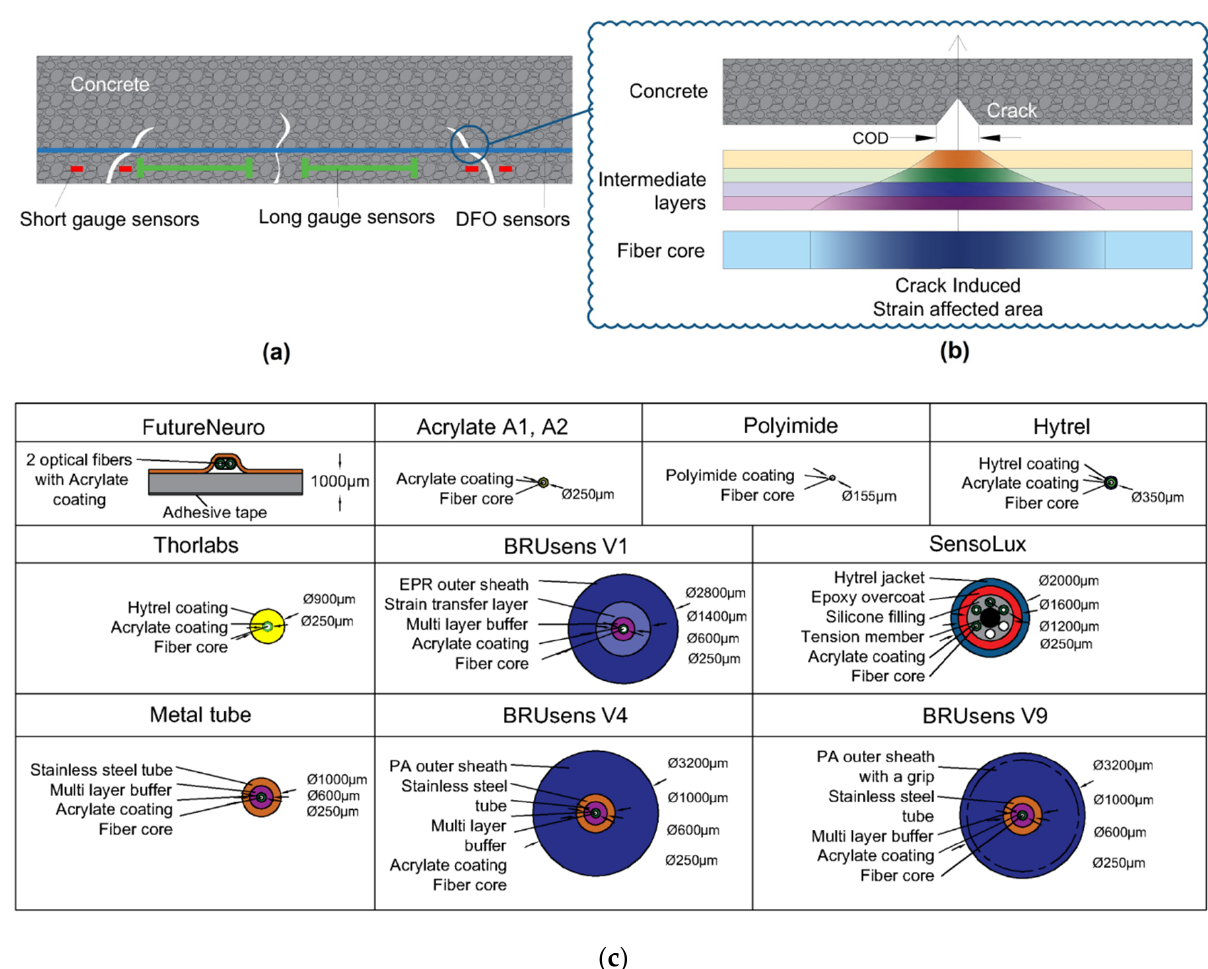
Figure 5. Crack detection using DOFS techniques: ( a ) Comparison of the traditional sensors, ( b ) strain transferring between layers and ( c ) the tested cables (adapted from